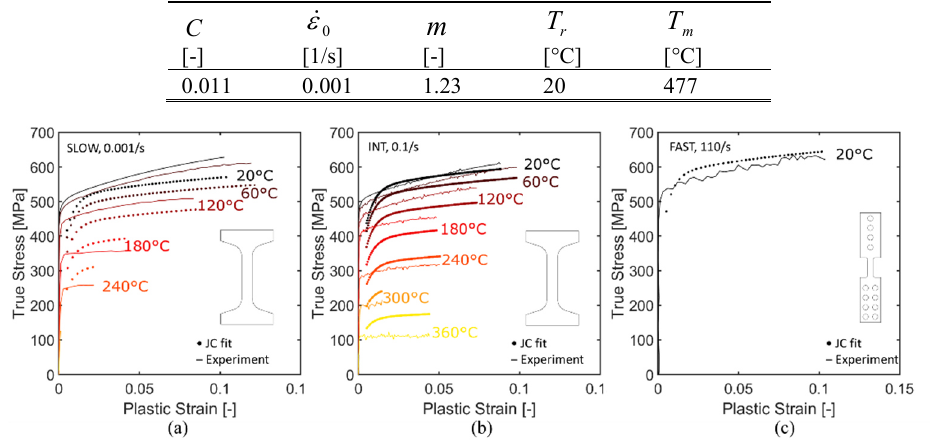
Fig. 3. Johnson-Cook model predicted hardening function (dots) against the experimental curves (solid lines).